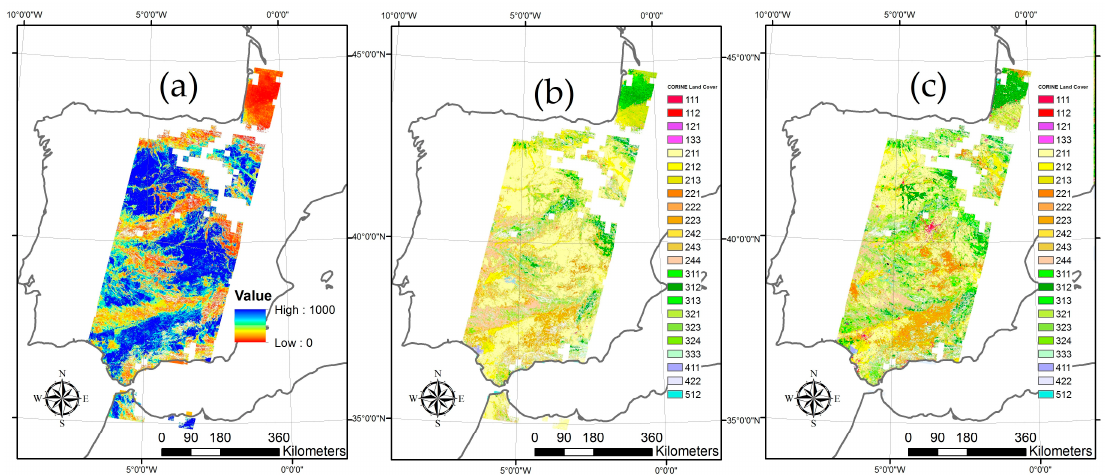
Figure 2. Example of maps obtained by using orbit 29476 corrected atmospherically, for 1000 classes, 100 iterations, and 12 bands. ( a ) Classified map with k-means classes; ( b ) Labeled map after k-means class aggregation; ( c ) Original CORINE land cover map.